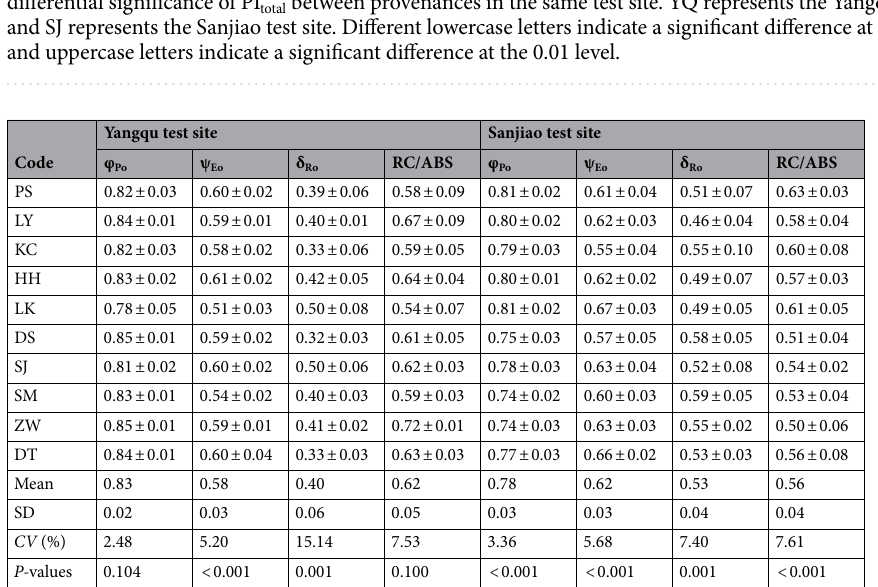
Table 4. φ Po , ψ Eo , δ Ro and RC/ABS analysis of Quercus liaotungensis seedlings between provenances. Mean and SD represent the average value and standard deviation of the parameter, respectively. CV and P -values represent the coefficient of variation and difference significance between provenances,